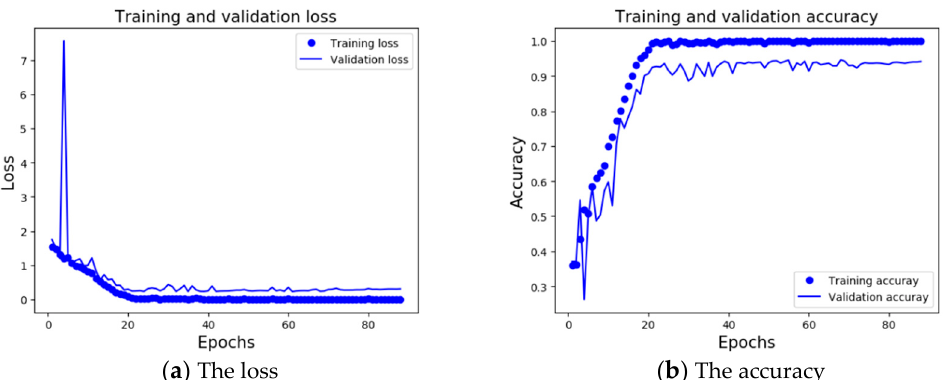
Figure 5. The training and validation accuracy and loss when training the model.